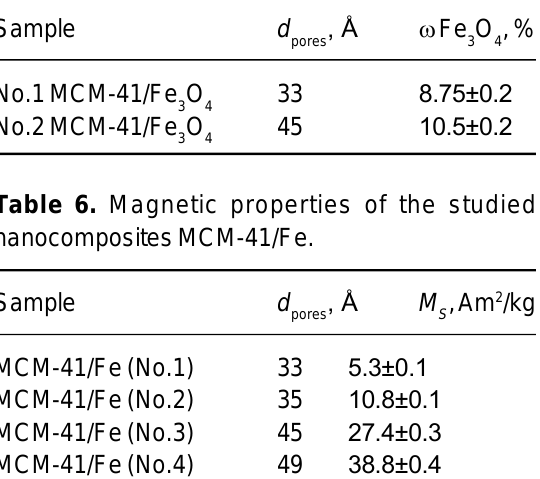
Table 5. Chemical composition of synthesized MCM-41/Fe